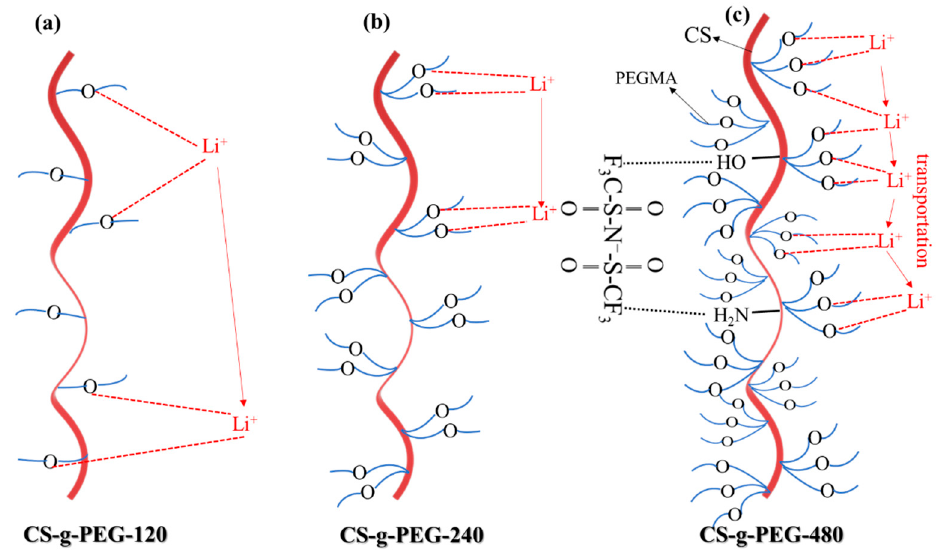
Scheme 2. The transport process of lithium ions in CS-g-PEG molecules. Figure 9a Evaluation of the electrochemical stability of CS-g-PEG-based GPE using linear sweep voltammograms (LSV) of Li/GPE/SS cells. The electrolyte with CS-g-PEG- 120 and CS-g-PEG-240 decomposes at about 4.9 V, while the electrolyte with CS-g-PEG- 480 decomposes at about 4.75 V and has a higher oxidation peak, which may be a result of the higher reactivity of CS-g-PEG-480 due to the more PEG segments on it [25]. The result indicates that CS-g-PEG can maintain excellent anodic stability at high voltages, and is a very promising GPE material for application.